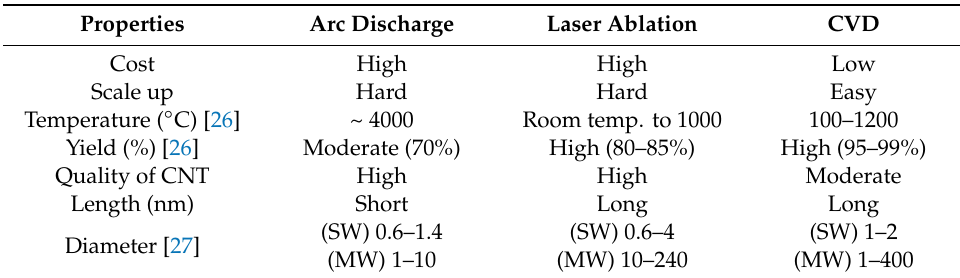
Table 1. Comparison among the well-established approaches for CNT